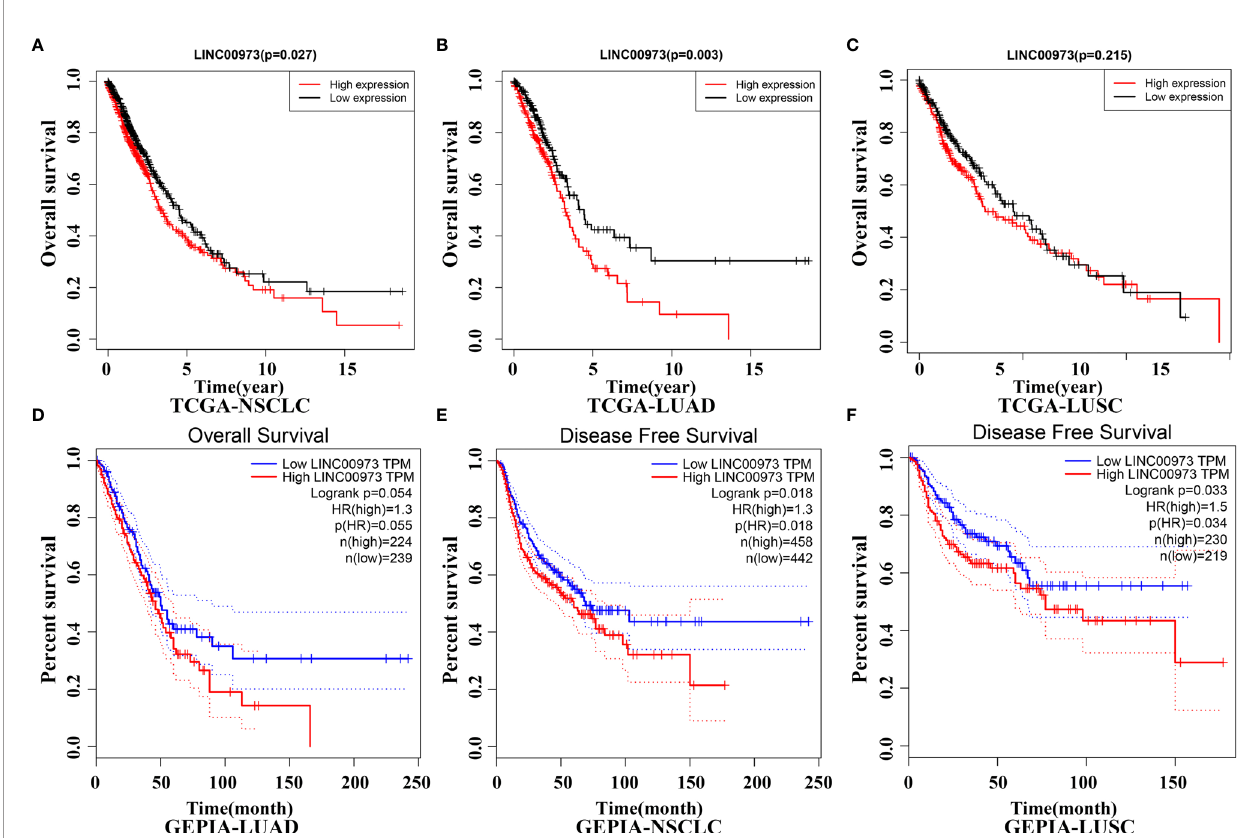
FIGURE 3 | NSCLC patients with elevated lncRNA expression have poor prognosis in TCGA and GEPIA databases. (A) TCGA-NSCLC-OS; (B) TCGA-LUAD-OS; (C) TCGA-LUSC-OS; (D) GEPIA-LUAD-OS; (E) GEPIA-NSCLC-DFS; (F) GEPIA-LUSC-DFS. NSCLC, Non-small cell lung cancer; LUAD, lung adenocarcinoma; LUSC, lung squamous cell carcinoma; TCGA, The Cancer Genome Atlas; GEPIA, Gene Expression Pro fi ling Interactive Analysis.